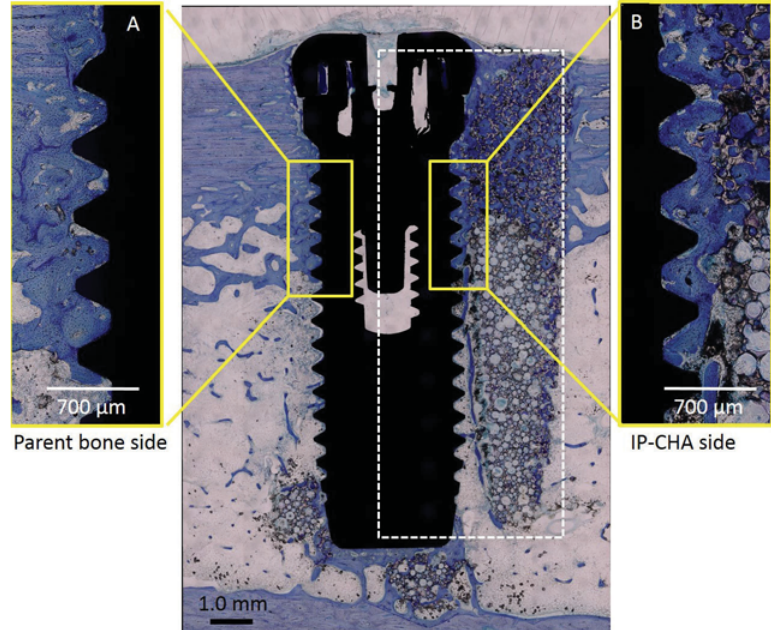
Figure 7- (cid:3)(cid:43)(cid:76)(cid:86)(cid:87)(cid:82)(cid:79)(cid:82)(cid:74)(cid:76)(cid:70)(cid:68)(cid:79)(cid:3)(cid:86)(cid:83)(cid:72)(cid:70)(cid:76)(cid:80)(cid:72)(cid:81)(cid:3)(cid:82)(cid:73)(cid:3)(cid:86)(cid:68)(cid:80)(cid:83)(cid:79)(cid:72)(cid:3)(cid:37)(cid:17)(cid:3)(cid:11)(cid:36)(cid:12)(cid:3)(cid:43)(cid:76)(cid:74)(cid:75)(cid:3)(cid:80)(cid:68)(cid:74)(cid:81)(cid:76)(cid:191)(cid:70)(cid:68)(cid:87)(cid:76)(cid:82)(cid:81)(cid:3)(cid:89)(cid:76)(cid:72)(cid:90)(cid:3)(cid:82)(cid:73)(cid:3)(cid:87)(cid:75)(cid:72)(cid:3)(cid:76)(cid:80)(cid:83)(cid:79)(cid:68)(cid:81)(cid:87)(cid:3)(cid:86)(cid:88)(cid:85)(cid:73)(cid:68)(cid:70)(cid:72)(cid:3)(cid:68)(cid:87)(cid:3)(cid:87)(cid:75)(cid:72)(cid:3)(cid:83)(cid:68)(cid:85)(cid:72)(cid:81)(cid:87)(cid:3)(cid:69)(cid:82)(cid:81)(cid:72)(cid:3)(cid:86)(cid:76)(cid:87)(cid:72)(cid:17)(cid:3) New bone formation from preexisting cortical bone was detected, showing that osseointegration was achieved; (B) High (cid:80)(cid:68)(cid:74)(cid:81)(cid:76)(cid:191)(cid:70)(cid:68)(cid:87)(cid:76)(cid:82)(cid:81)(cid:3)(cid:82)(cid:73)(cid:3)(cid:87)(cid:75)(cid:72)(cid:3)(cid:76)(cid:80)(cid:83)(cid:79)(cid:68)(cid:81)(cid:87)(cid:3)(cid:86)(cid:88)(cid:85)(cid:73)(cid:68)(cid:70)(cid:72)(cid:3)(cid:68)(cid:87)(cid:3)(cid:87)(cid:75)(cid:72)(cid:3)(cid:44)(cid:51)(cid:16)(cid:38)(cid:43)(cid:36)(cid:3)(cid:86)(cid:76)(cid:87)(cid:72)(cid:17)(cid:3)(cid:49)(cid:72)(cid:90)(cid:3)(cid:69)(cid:82)(cid:81)(cid:72)(cid:3)(cid:73)(cid:82)(cid:85)(cid:80)(cid:72)(cid:71)(cid:3)(cid:76)(cid:81)(cid:3)(cid:87)(cid:75)(cid:72)(cid:3)(cid:44)(cid:51)(cid:16)(cid:38)(cid:43)(cid:36)(cid:3)(cid:83)(cid:82)(cid:85)(cid:72)(cid:86)(cid:3)(cid:76)(cid:81)(cid:3)(cid:70)(cid:82)(cid:81)(cid:87)(cid:68)(cid:70)(cid:87)(cid:3)(cid:90)(cid:76)(cid:87)(cid:75)(cid:3)(cid:87)(cid:75)(cid:72)(cid:3)(cid:76)(cid:80)(cid:83)(cid:79)(cid:68)(cid:81)(cid:87)(cid:3) surface, showing that osseointegration was achieved. The bottom portion of the IP-CHA pores contained small amounts of new bone. (The dotted line indicates placed IP-CHA)